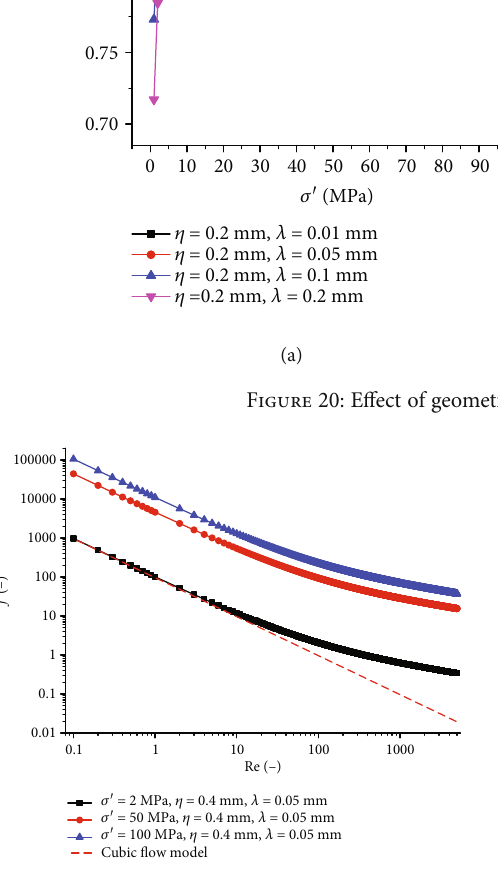
Figure 21: Friction factor vs. loading stress under the same geometry parameters η and λ